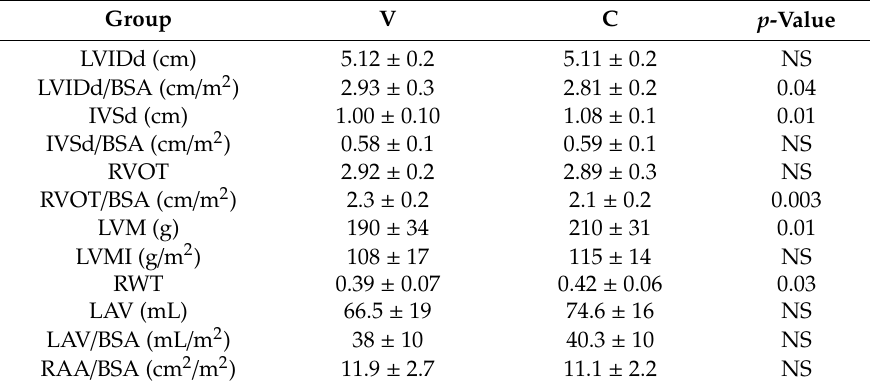
BSA—body surface area indexation; IVSd—interventricular septum thickness at end-diastole; RVOT—right ventricular outflow tract; LVM—left ventricular mass; LVMI—left ventricular mass index; RWT—relative wall thickness; LAV—left atrial volume; RAA—right atrial